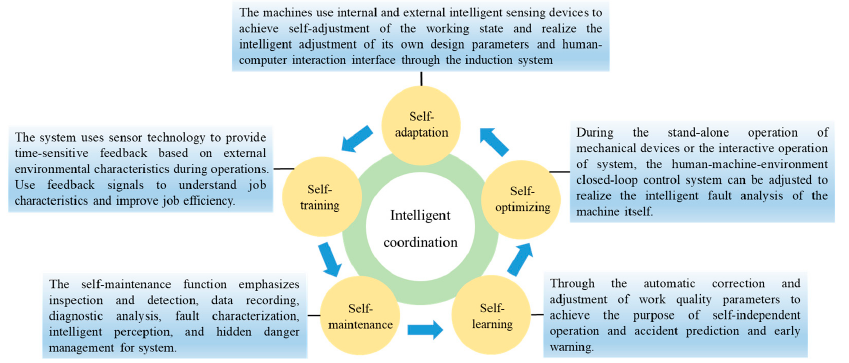
Figure 9. The function of intelligent coordination and its specific interpretation. By improving the intelligent coordination function of the system and integrating it into all aspects of system analysis, intrinsic safety and cleaner production can be